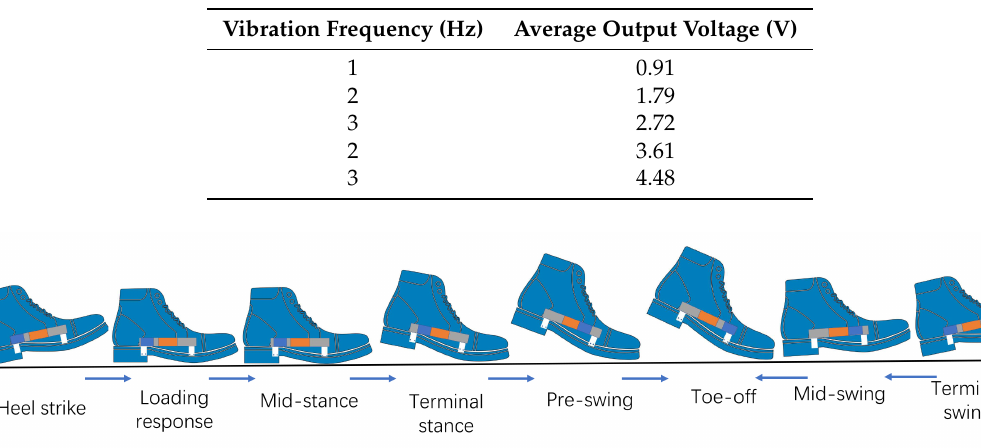
Figure 4. The process of generating electricity. The blue part indicates the magnet, and the brown part indicates the coil, the direction of the arrow indicates the direction of the magnet